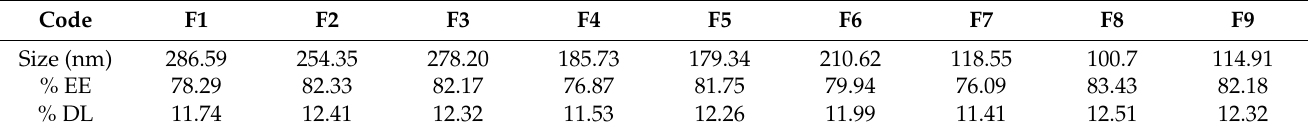
Table 1. The characterisation of various developed microemulsion formulations.